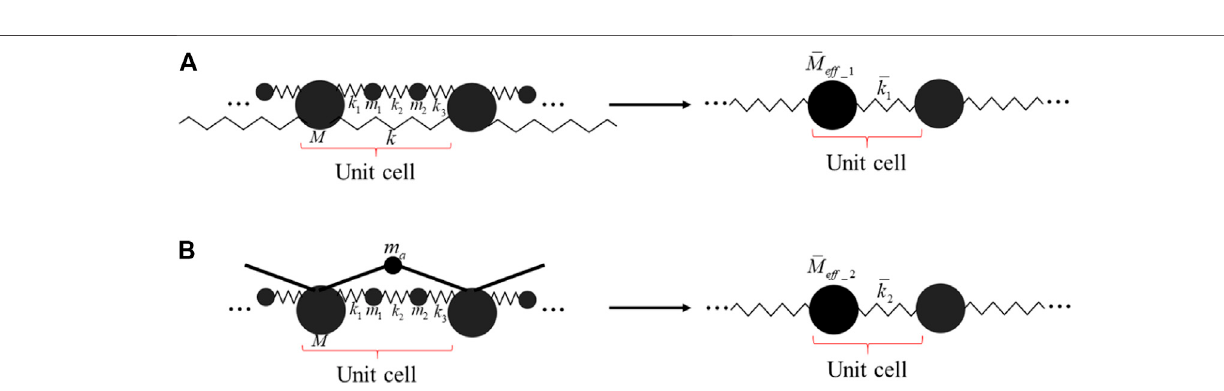
FIGURE 9 | State “ LL ” : (A) the dispersion curves ab and cd veer apart in dotted circle region. (B) Enlarged view of the veering region.